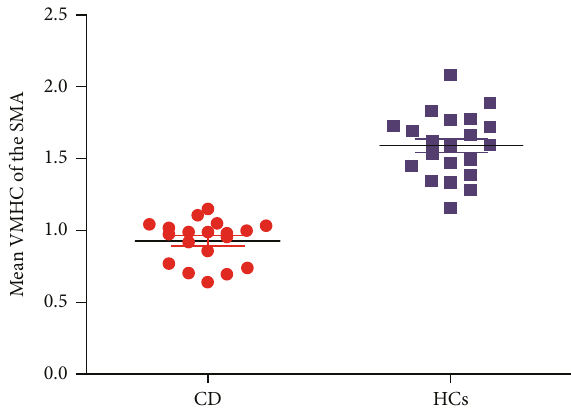
Figure 5: The scatterplot representing group comparisons of the mean VMHC values in the SMA. SMA=supplementary motor area; VMHC=voxel-mirrored homotopic connectivity; CD=cervical dystonia; HCs=healthy